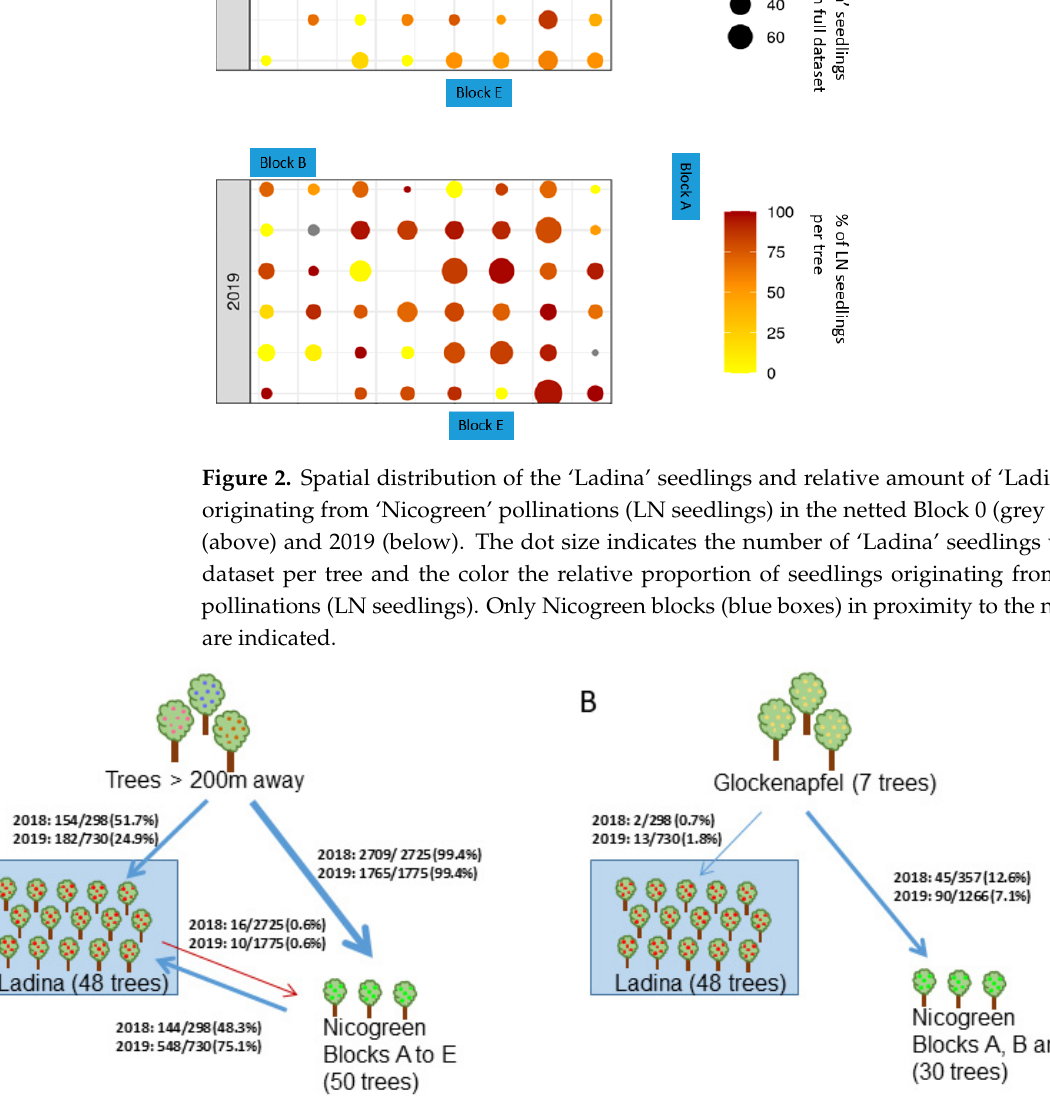
Figure 3. ( A ) Summary of the detected pollination events between ‘Ladina’ (in Block 0, blue box) and ‘Nicogreen’ (in Blocks A to E outside the netted Block 0), as well as those between unknown trees with ‘Ladina’ and ‘Nicogreen’. The ‘Glockenapfel’ pollinations are included in the “trees >200 m away” group. ( B ) Summary of the detected pollination events between ‘Glockenapfel’ and ‘Ladina’ as well as ‘Glockenapfel’ and ‘Nicogreen’ (Blocks A, B, and E). ‘Glockenapfel’ trees are located approximately 300 m from the centre of Block 0. The pollination events are displayed per year and as fractions of seedlings with full SSR dataset. Arrow thickness represents importance of the pollination route. The red arrow indicates the ‘Ladina’ outcrossing events. The efficiency of the netting system to prevent the ingress of pollen into the experimental area was estimated by comparing the realised pollen dispersal from the ‘Glo-ckenapfel’ trees, which were situated approximately 300 m from the centre of Block 0 and the ‘Nicogreen’ trees of Blocks A, B and E combined. Two out of 298 ‘Ladina’ seedlings (0.7%) and 45 out of 357 (12.6%) ‘Nicogreen’ seedlings in Blocks A, B and E were derived from fertilisation by ‘Glockenapfel’ in 2018 (Figure 3B). This corresponds to an 18-fold reduction of realised pollen dispersal by the netting system. In 2019, 13 of the 730 ‘Ladina’ seedlings (1.8%) were LG while 90 out of 1266 ‘Nicogreen’ seedlings (7.1%) in Block A, B and E were NG. This corresponds to a four-fold reduction of ‘Glockenapfel’ fertilisations inside the netting system compared to fertilisations outside the netted Block 0. 4. Discussion Our study suggests that the netting system allows little ingress/egress of pollen in Block 0. Within the netted Block 0, an average of 350 apples developed each year, corresponding to approximately seven apples per ‘Ladina’ tree. Moreover, some apples developed parthenogenetically and did not contain seeds (Table 5), while others Commented [M4]: Final check revision 4: There is the revised version of Figure 3.